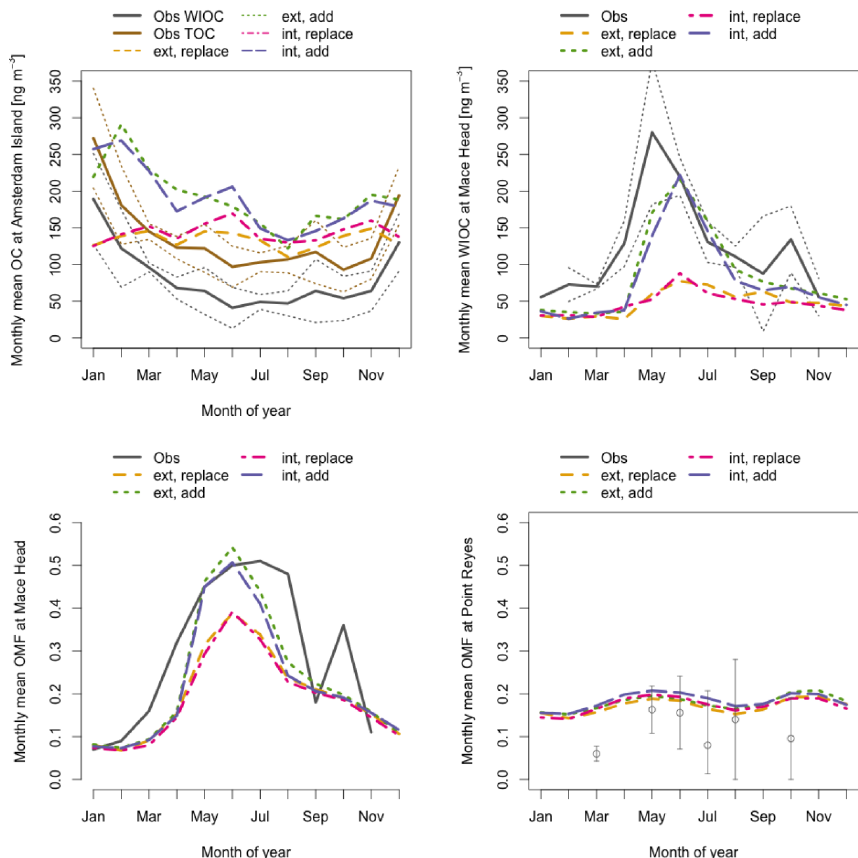
Figure 3. Top: observed and simulated seasonal cycle, observed water-insoluble organic carbon (WIOC), and total organic carbon (TOC) in aerosol versus modeled marine organic carbon (MOC; converted from marine OM using OM : OC = 1.8), at Amsterdam Island (left: d < 1.0µm; Sciare et al., 2009) and Mace Head, Ireland (right: d < 1.5µm; Rinaldi et al., 2013). Note that the Mace Head samples were selected for “clean marine” conditions as described in Rinaldi et al. (2013) and that pristine conditions typically prevail at Amsterdam Island. Dashed lines represent the standard deviation of measurements from the same month, where more than one observation was available for a given month. Bottom: observed and simulated seasonal cycle, organic mass fraction of aerosol as reported under clean marine sampling conditions. Left: Mace Head, Ireland ( d < 1.5µm; Rinaldi et al., 2013); right: Point Reyes, California ( d < 2.5µm; Gantt et al.,